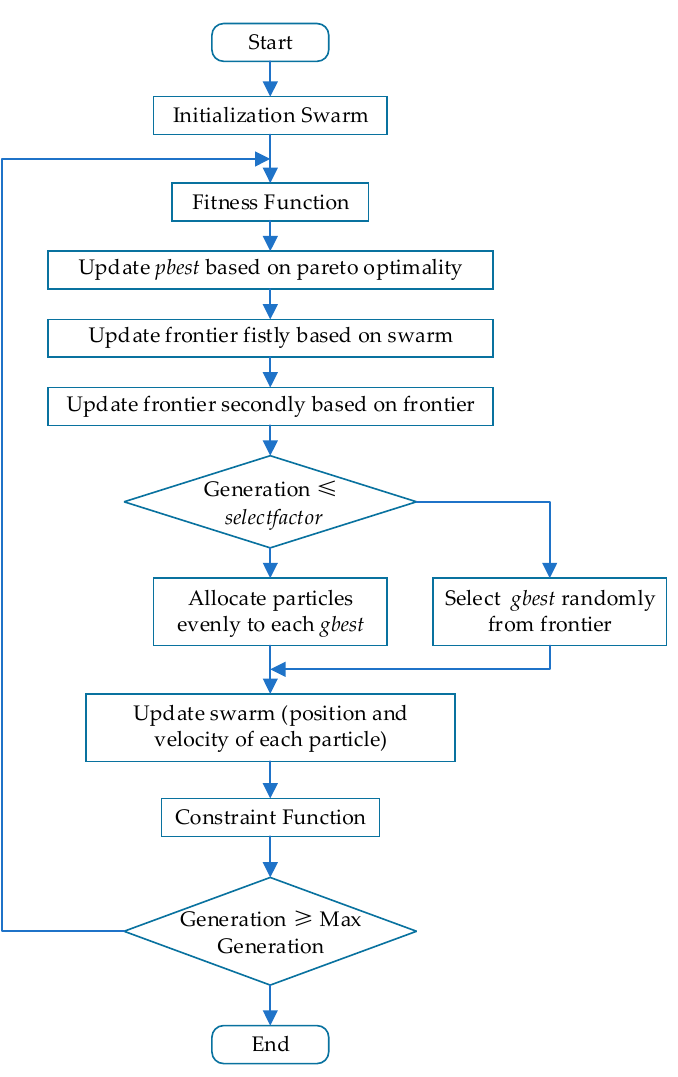
Figure 4. Scheme of improved multi-objective particle swarm optimization (MOPSO).